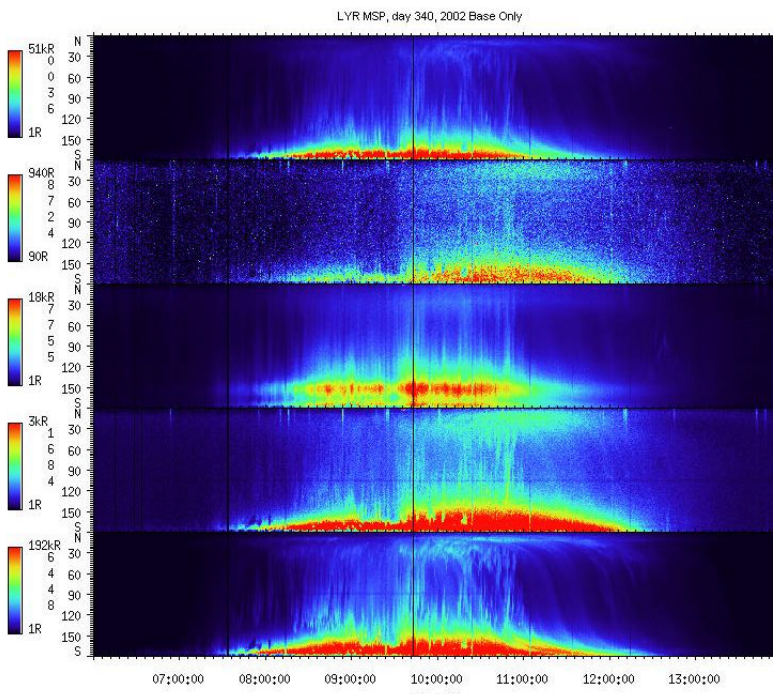
Fig. 2. Meridian Scanning Photometer (MSP) data (BASE Only) from the Auroral Station in Adventdalen, Norway, 06:00–14:00 UT, 6 December 2002. The intensities are indicated as coloured bars to the left for each channel with centre wavelengths 6300, 4278, 5577, 4861 and 8446 ˚A, respectively. The intensities are in kilo Rayleighs [kR]. South is 180 ◦ in scan angle. Note that solar depression angles were 12.6 ◦ , 10.7 ◦ , and 11.8 ◦ at 08:30 UT, 10:30 UT and 12:30 UT, respectively.